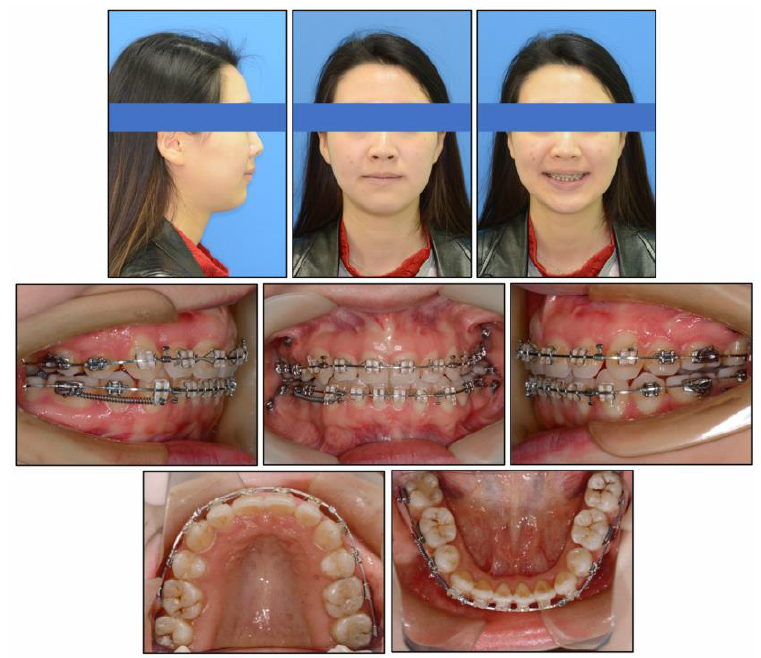
Figure 6. Twenty-seven months into treatment, 0.019 × 0.025-inch stainless steel archwires was used to close the residual spaces of both arches with spring to the miniscrews.